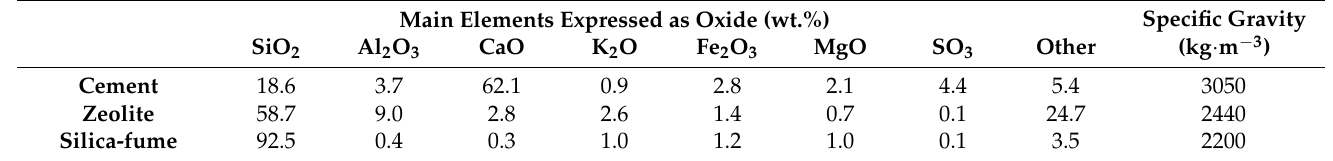
Table 1. Chemical composition and specific gravity of the binding materials used. Main Elements Expressed as Oxide